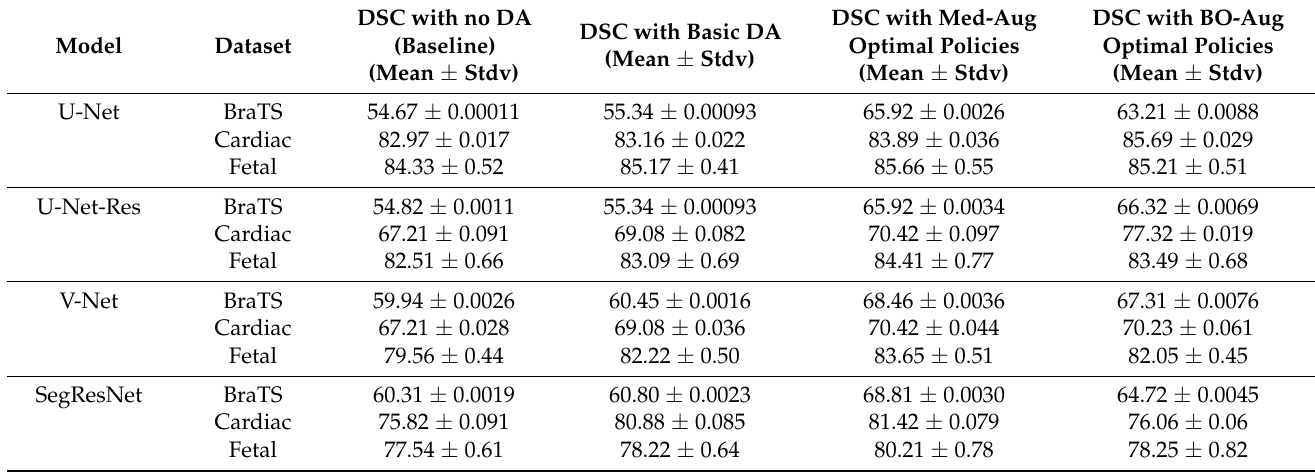
Table 2. Testing performance in DSC of four different neural networks using different DA policies on the training set. (IoU version of the table is found in Appendix